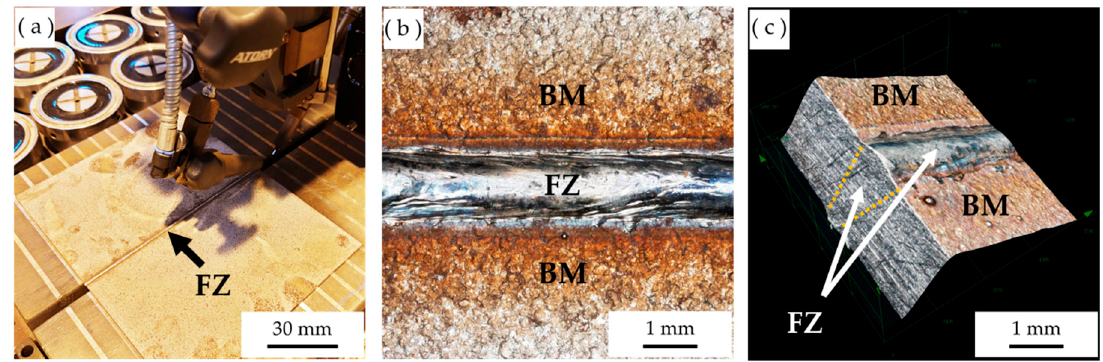
Figure 1. ( a ) The infrastructure of high-power disk laser welding the steel plate in laboratory, ( b ) the top view of laser weldment, ( c ) 3D synthesis image of the laser weldment.